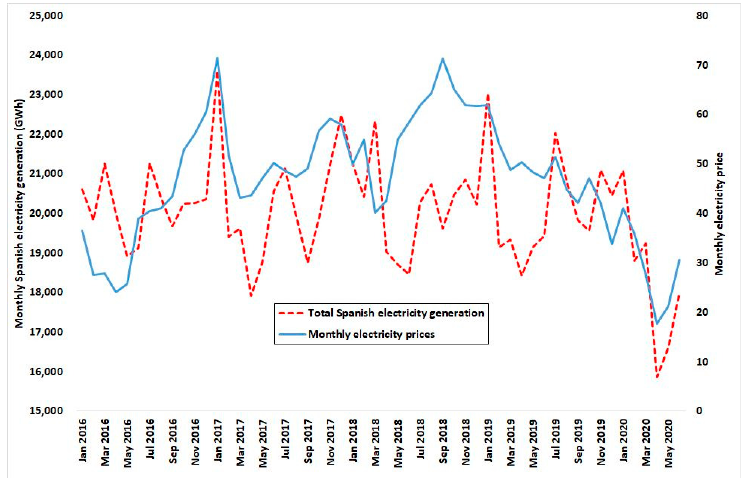
Figure 1. Spanish monthly electricity generation and prices, from January 2016 to June 2020. Source: own work based on ESIOS [5].